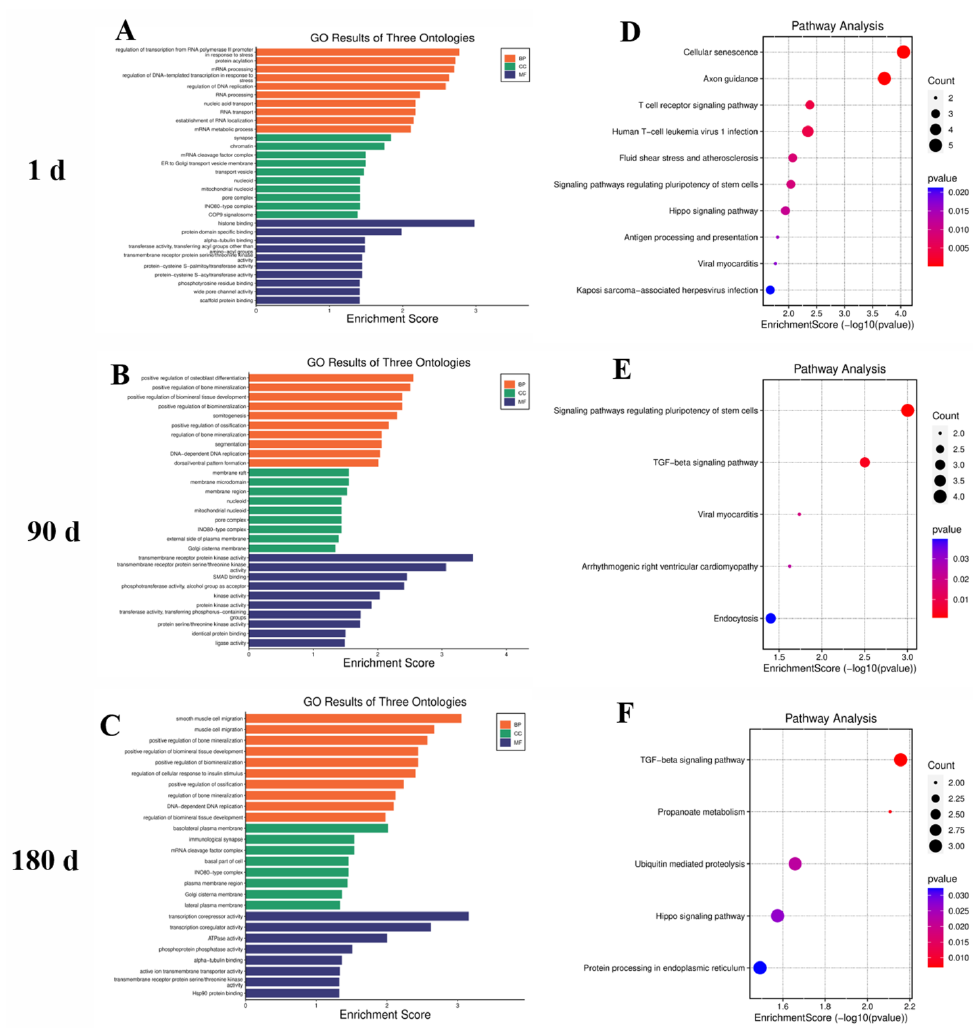
Figure 2. Functional enrichment results of the host genes of DEcircRNAs. ( A , D ): GO and KEGG analysis at 1 day of age; ( B , E ): 90 days of age; and ( C , F ): 180 days of age.